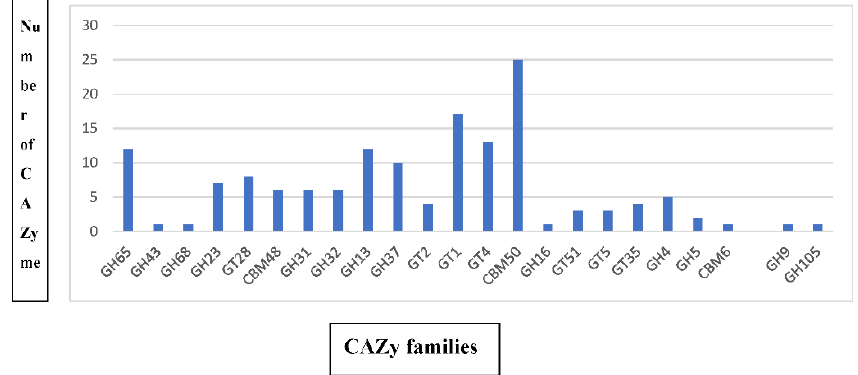
Figure 3. Distribution of the carbohydrate active enzyme (CAZy) family protein identified in the genome of B. subtilis Bbv57.